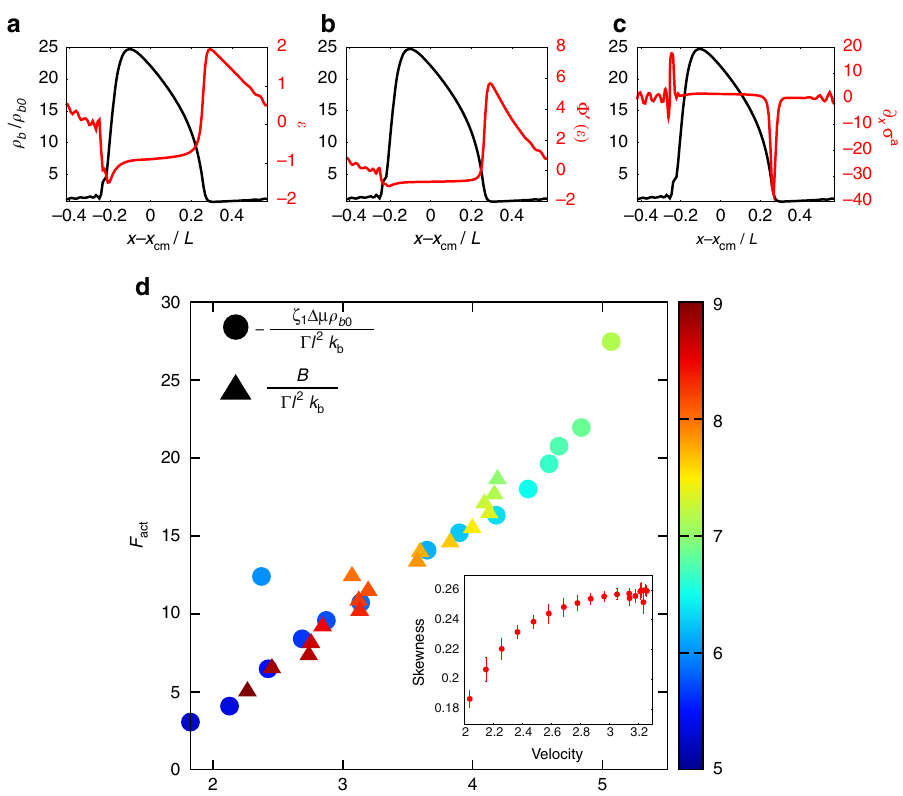
Fig. 5 Anatomy of the traveling front in the co-moving frame: a Spatial pro fi le of excess bound-myosin density (black) and strain ϵ (red) pro fi le, b Spatial pro fi le of Myosin density and derivative of the effective elastic free energy Φ ′ ( ϵ ) (red), c Spatial pro fi le of myosin density and active force (red). Horizontal axis is distance from centre of mass position, x CM . Here B = 6.0, − ζ 1 Δ μ = 4.8, k = 0.2, α = 1.0 and D = 0.25. d Theory predicts that the traveling front velocity is proportional to the net active force integrated over the front pro fi le across the moving front. We demonstrate this fact from a numerical solution of the dynamical equations by varying the parameters of the active stress (circle) and the elastic stress (triangle). for different values of B (with − ζ 1 Δ μ = 6.0, k = 0.2 and D = 0.15 fi xed) and − ζ 1 Δ μ (with B = 8.0, k = 0.2 and D = 0.15 fi xed). Rest of the parameters as in Fig. 2.The color bar shows the magnitude of these stresses in dimensionless units. (inset) Skewness of bound myosin pro fi le in the traveling front vs. velocity, obtained by varying the contractile stress − ζ 1 Δ μ from 3 – 4 shows a linear increase followed by saturation. The other dimensionless parameters are: B = 4, k = 0.2, D = 0.1, α = 1 and c = 0.1. The error bars are calculated as